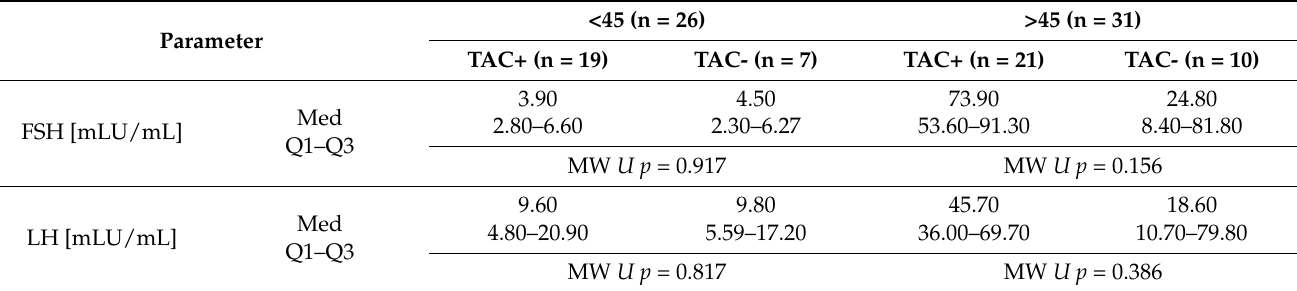
Table 4. Hormone and TAC concentrations in blood of female renal transplant recipients under and over 45 years old.